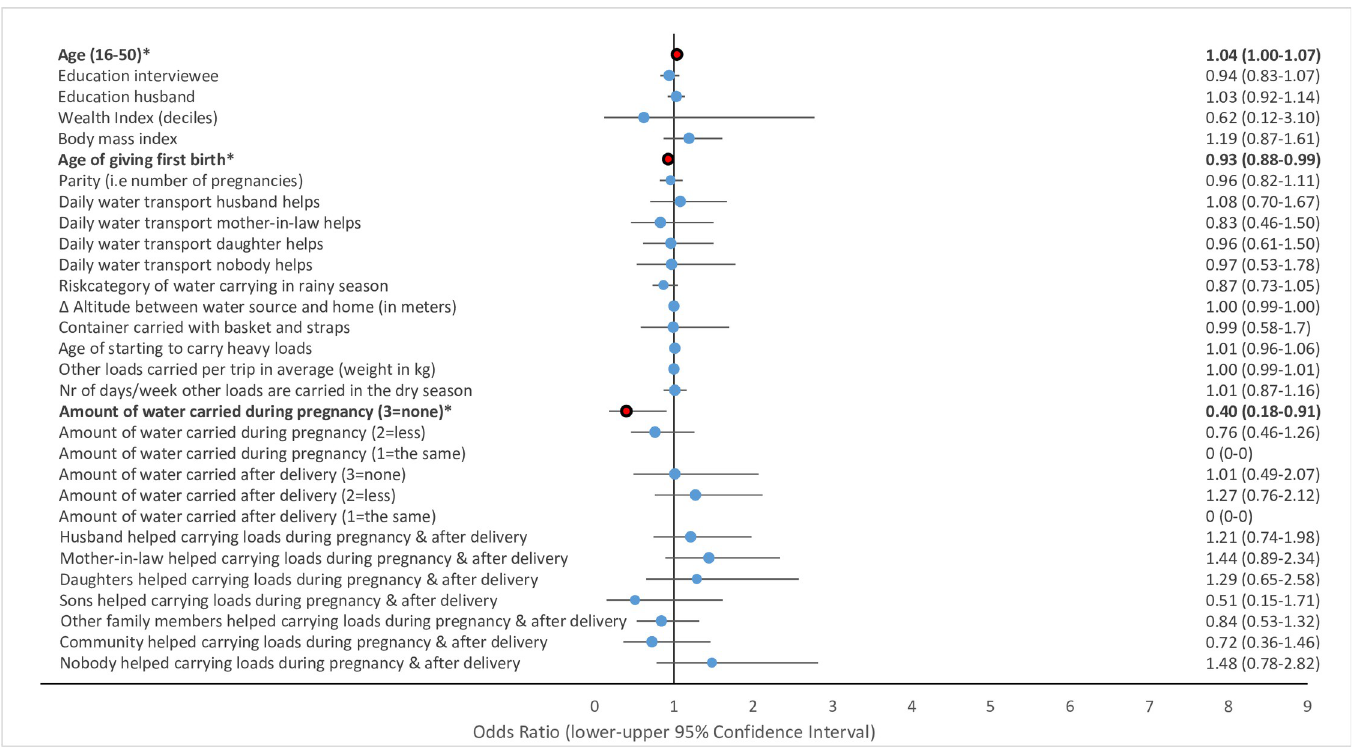
Fig 6. Association of risk factors with spontaneous abortions in multivariate GLMM. ( ��� = significant at the p < 0.001-level, �� = significant at the p = 0.01-level, � = significant at the p = 0.05-level; = odds ratio statistically non-significiant, ... = odds ratio statistically significant).